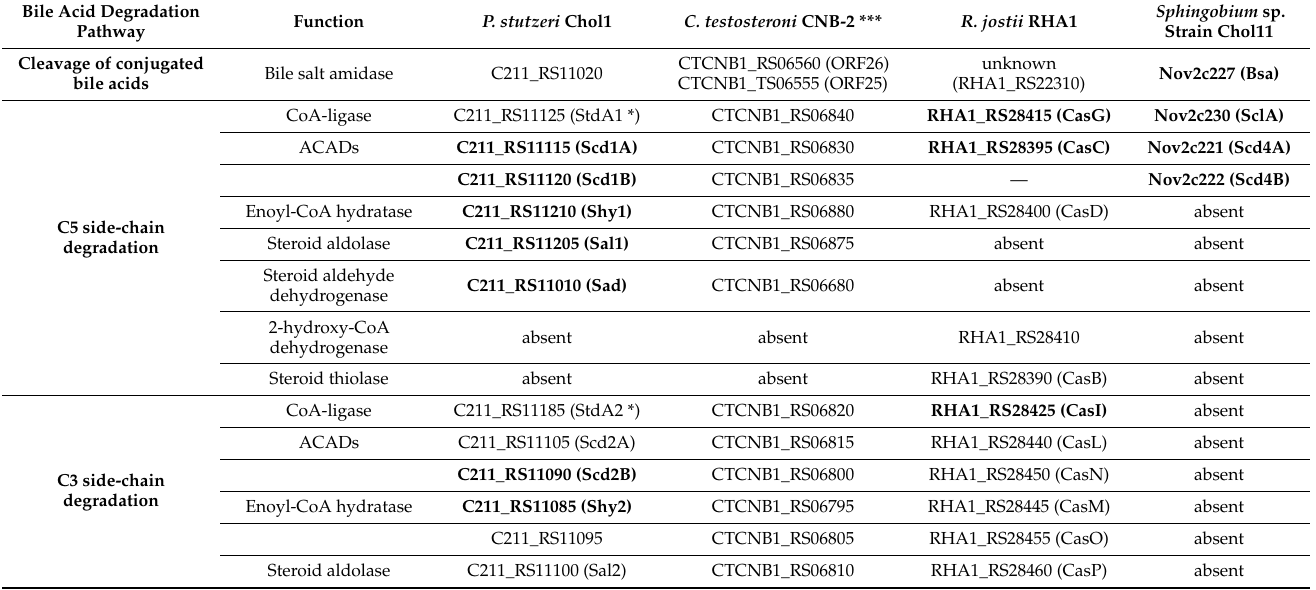
Table 1. Characterized and predicted bile acid degradation genes (locus tags) located in the steroid degradation gene clusters of Pseudomonas stutzeri Chol1, Comamonas testosteroni CNB-2, Rhodococcus jostii RHA1, and Sphingobium sp. strain Chol11. Protein names are given in parentheses when available and are taken from the corresponding literature. Characterized genes and proteins are